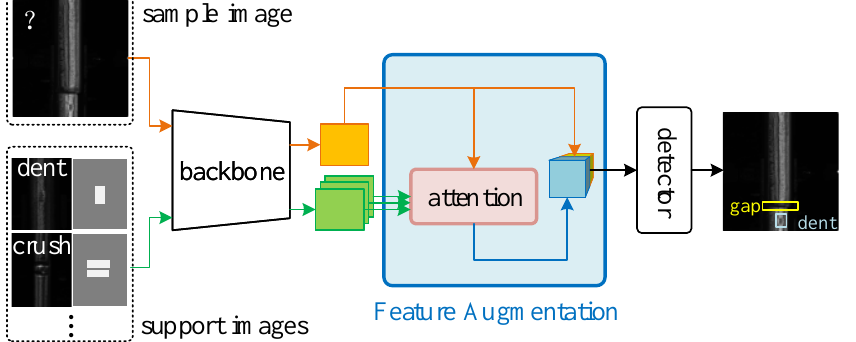
Figure 2. The architecture of the rail defect detection